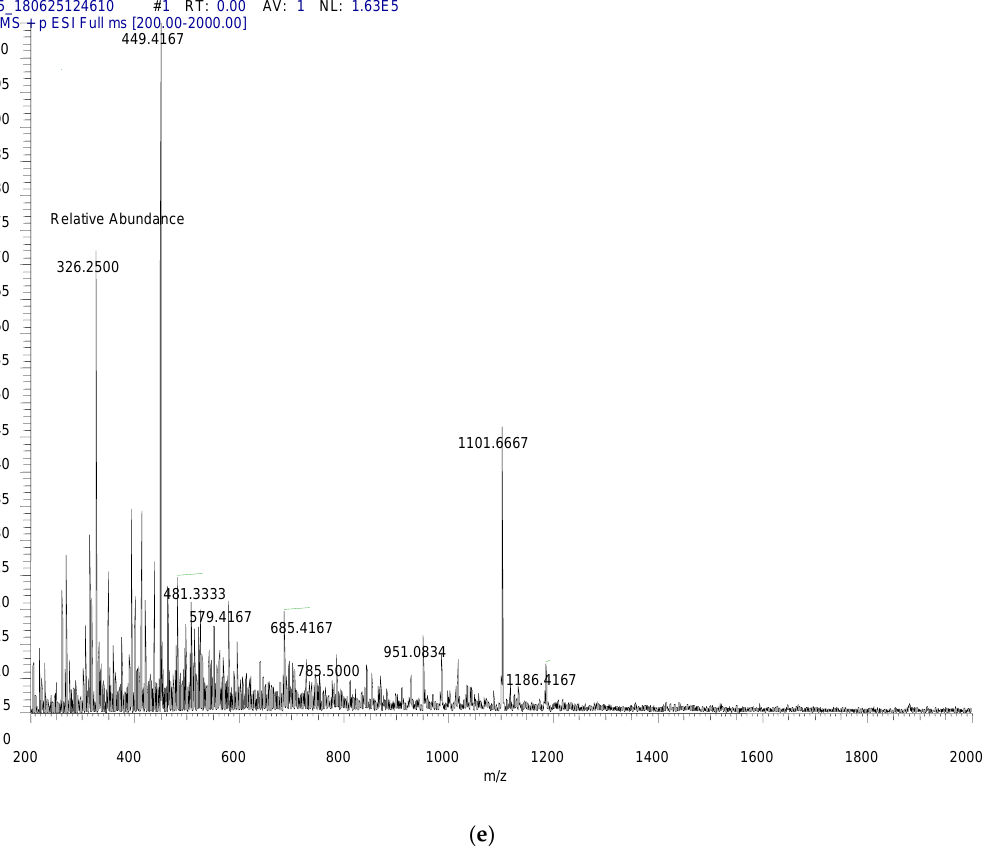
Figure A7. ( a ) 1 HNMR spectrum of compound 7 . ( b ) 13 CAPT spectrum of compound 7 . ( c ) HSQC spectrum of compound 7 . ( d ) HMBC spectrum of compound 7 . ( e ) ESIMS spectrum of compound 7 .